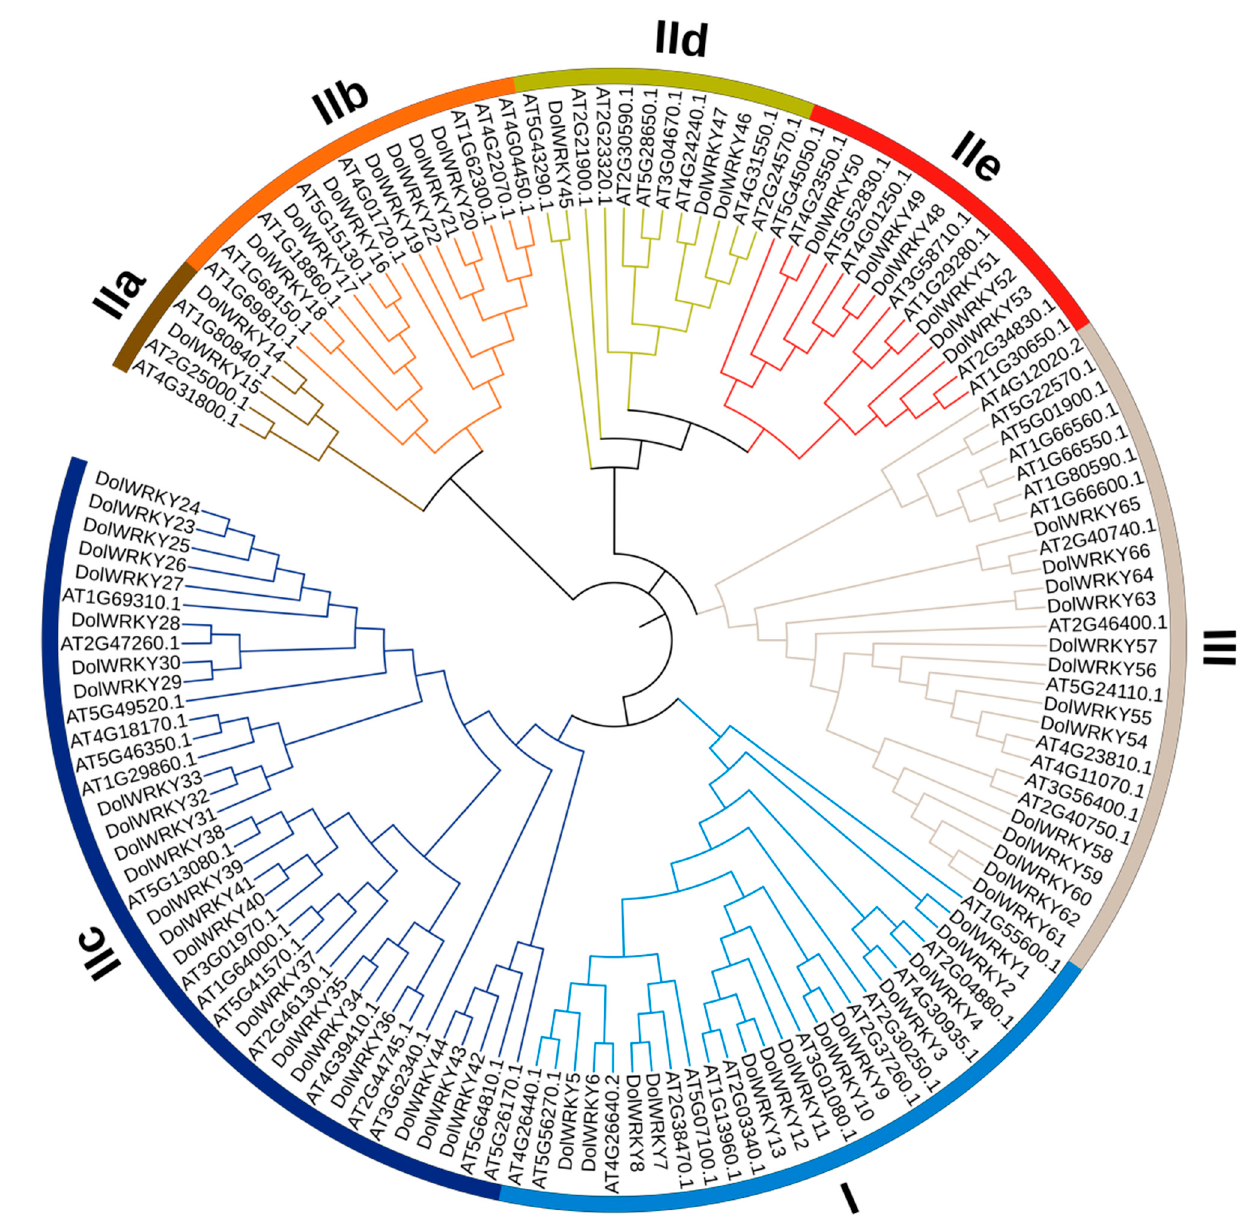
Figure 5. Phylogenetic showing the WRKY genes in D. oleifera . The tree was visualized with the iTOL program. Different colours represent different groups.